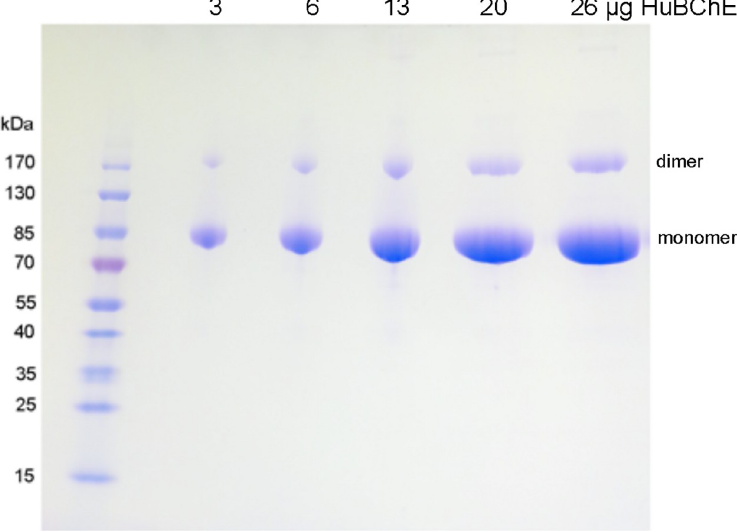
Fig 8. SDS polyacrylamide gel of 99% pure HuBChE purified by the method described in this report. HuBChE monomers are at 85 kDa and nonreducible dimers are at 170 kDa.